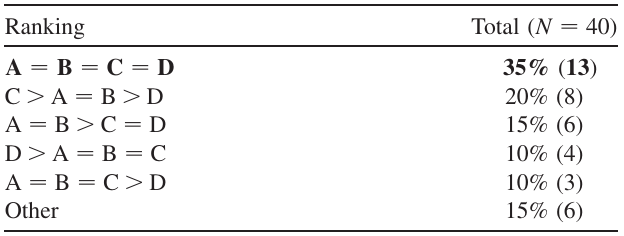
TABLE IV. Bulb rankings in the multiple batteries in multiple loops pretest of Fig.